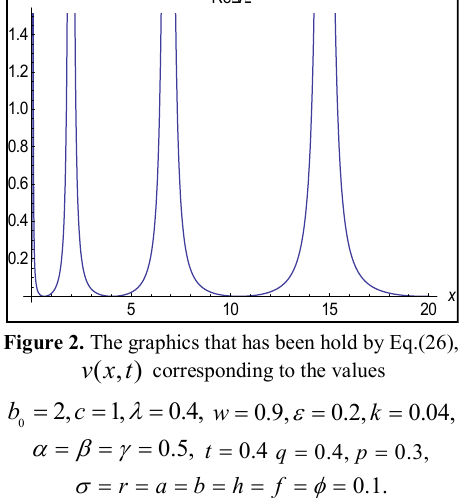
Figure 2. The graphics that has been hold by Eq.(26), ( , ) v x t corresponding to the